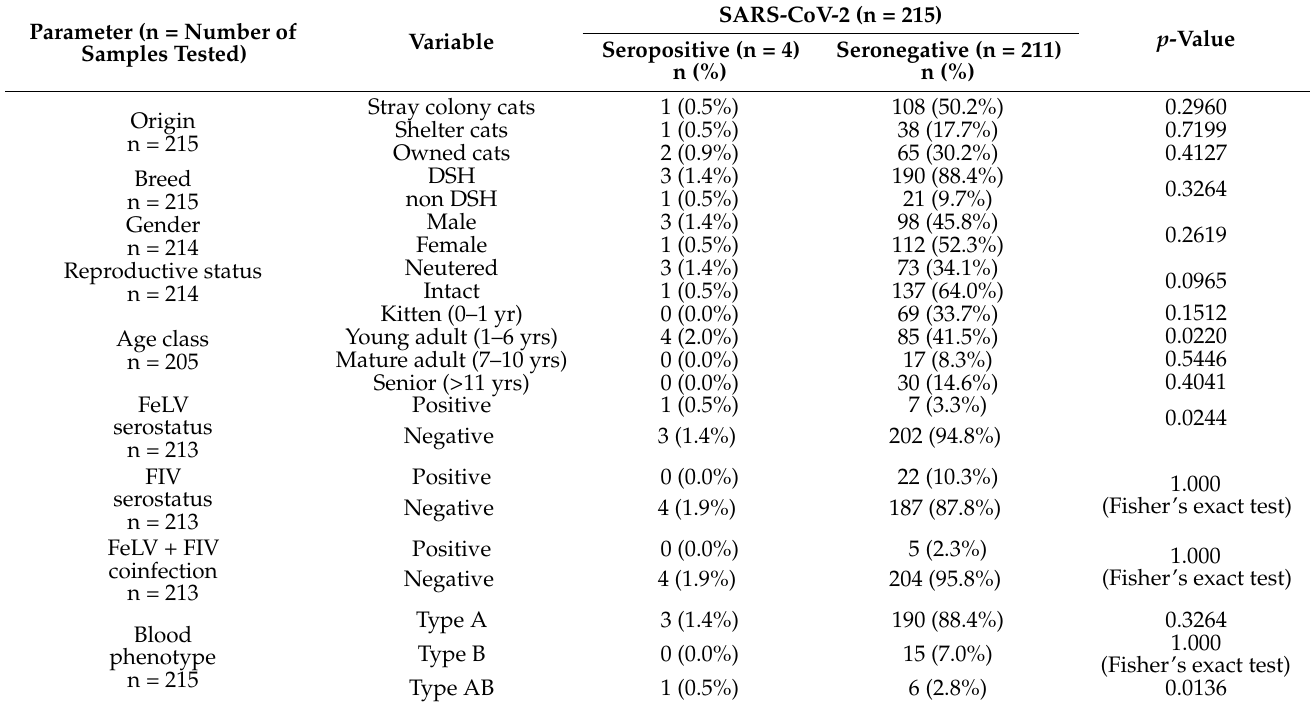
Table 1. Characteristics of an Italian feline population of 215 cats investigated for association between blood phenotype and antibodies against severe acute respiratory syndrome coronavirus 2 (SARS- CoV-2) and analysis for factors associated with seropositivity according to univariate analysis with chi square test or Fisher’s exact test.